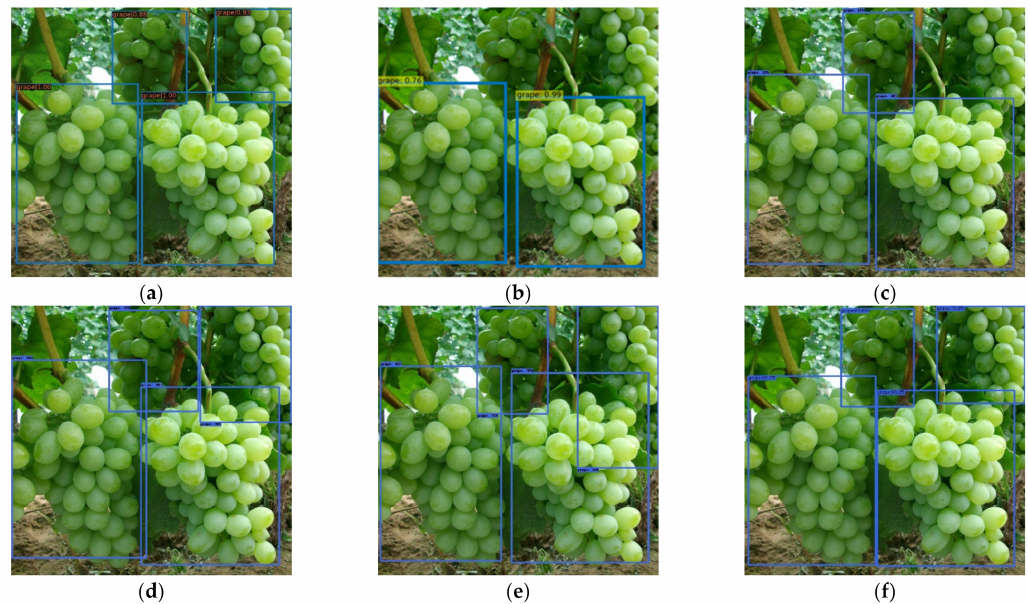
Figure 10. Bunches of green grapes detection in case 1: ( a ) SwinGD, ( b ) DETR, ( c ) YOLOv3-SPP, ( d ) Faster-RCNN, ( e ) SSD, ( f )